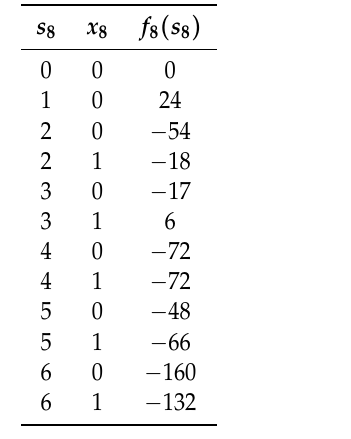
Table 6. Functions f 8 ( s 8 )